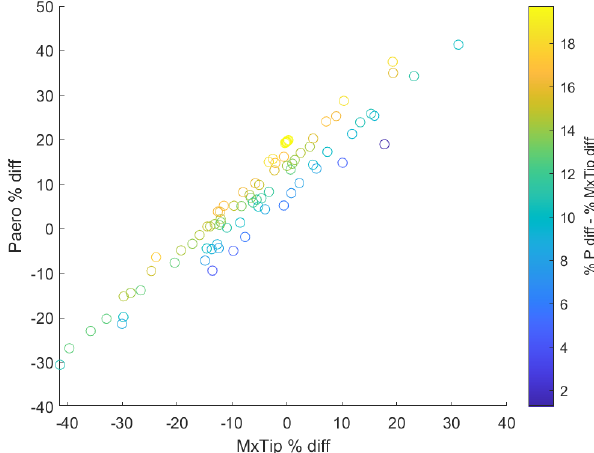
Figure 2. Pareto front of the optimization objectives (horizontal axis: change in flapwise bending moment at tip connection com- pared to baseline, vertical axis: change in aerodynamic power com- pared to baseline, color bar: summed difference in power and flap- wise